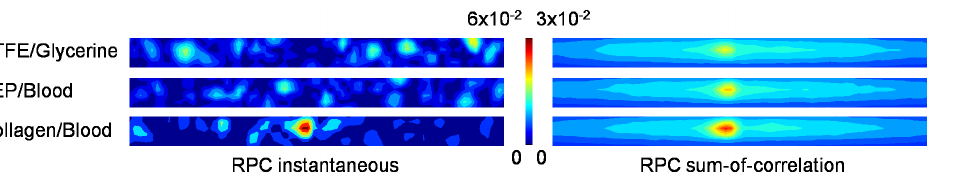
Figure 9. Contours of RPC instantaneous and sum-of-correlation planes. The contour indicates relative correlation magnitude. Only the central 50% window is shown.